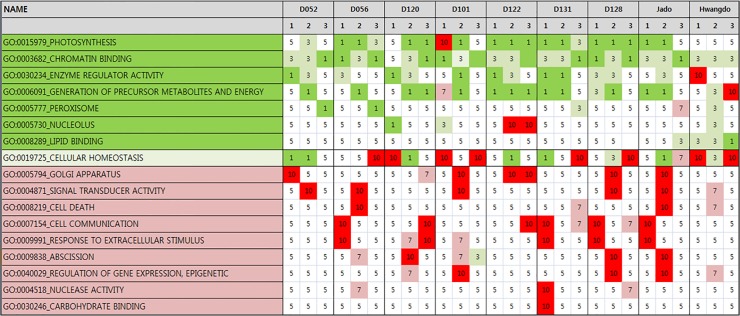
Genome-wide expression profiles from the RNA-seq experiments with 10 rice accessions.Expression values were generated by the GSEA method using FPKM values. The expression of photosynthesis-related genes (GO:0015979) was decreased in all the rice accessions. The GO categories were selected by p-value (≤ 0.05) cutoff, and green and red colors represent down-regulated and up-regulated categories, respectively.